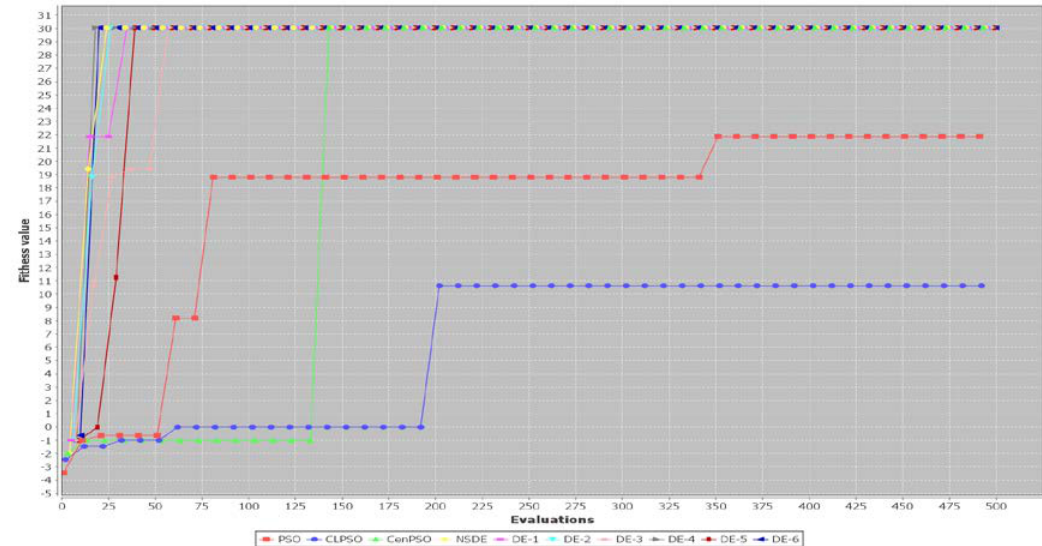
Figure A5. Convergence speed of a run of each algorithm for Case 5 with POP = 30.